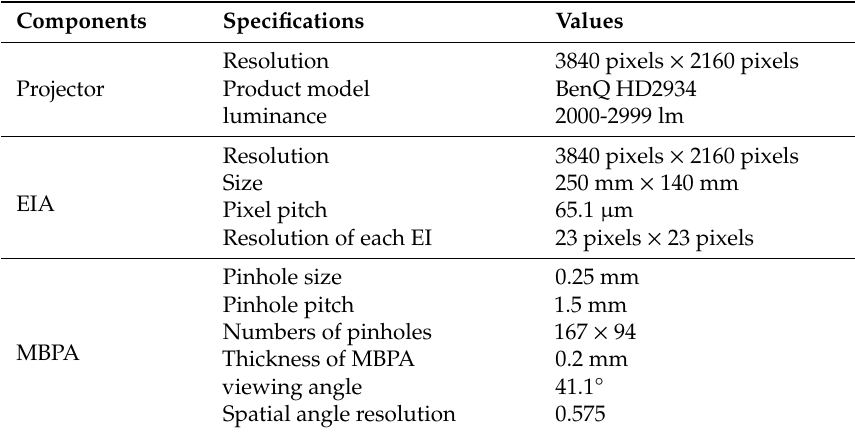
Table 1. Specifications of the AR display system developed.